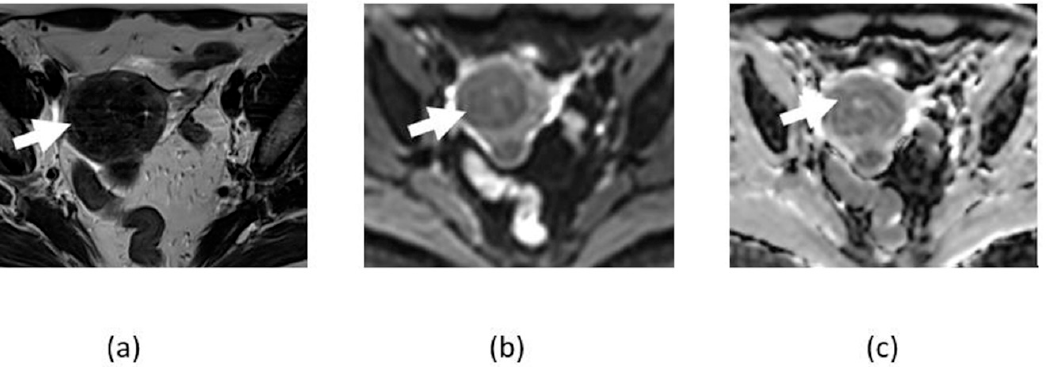
Figure 1. Axial T2-weighted image ( a ) showing hypointense lesion in the uterus fundus consistent with leiomyoma (arrows). The lesion shows low signal on DWI ( b ) and ADC map ( c ), consistent with absence of restricted diffusion.